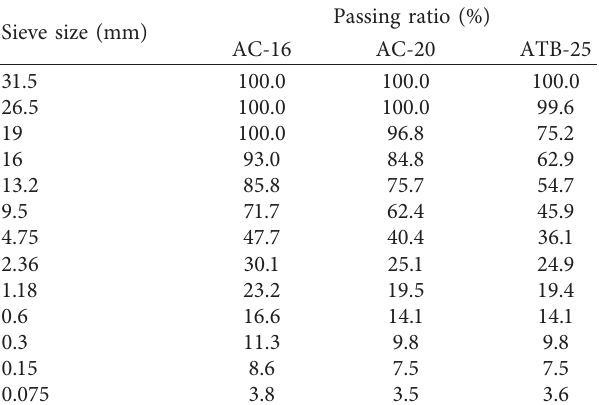
Table 3: Gradation composition of steel slag asphalt